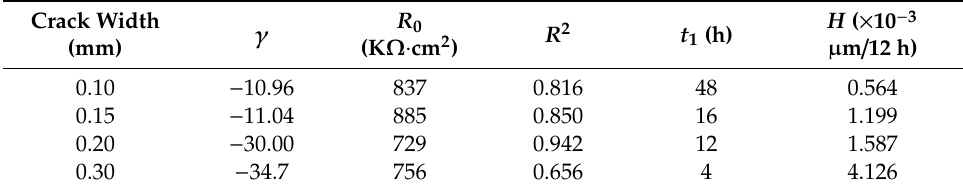
Table 6. Depassivation time and corrosion rate of steel bars in concrete with different crack widths in an electric field.